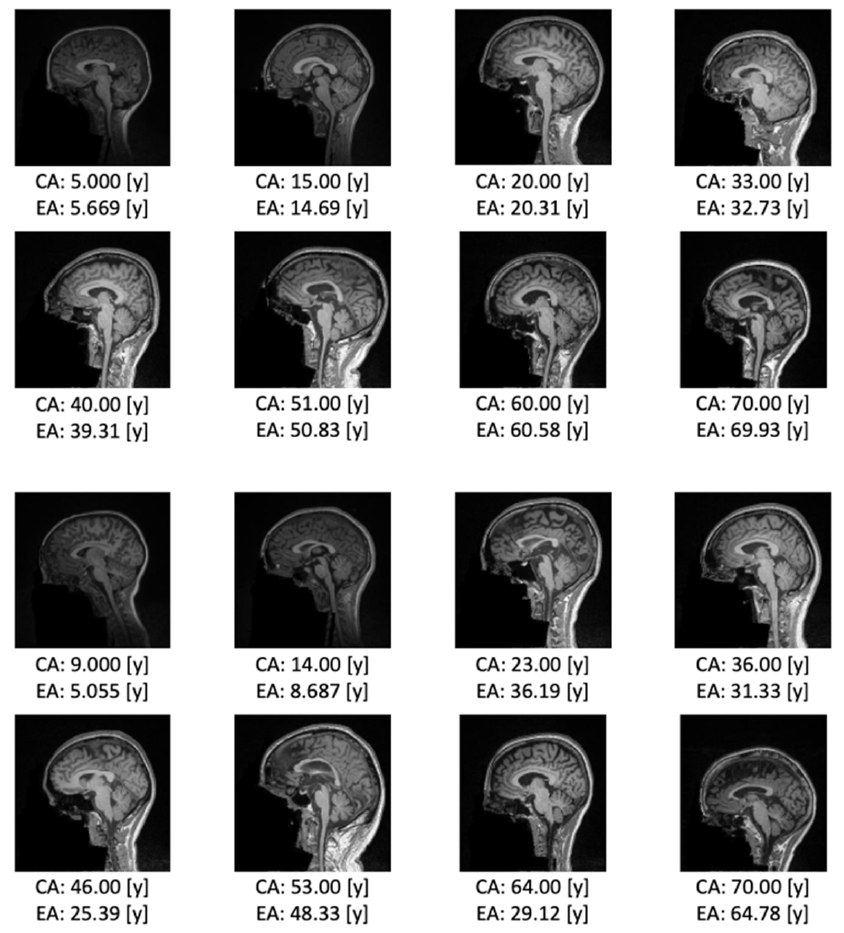
Figure 9. Typical example of this age estimation method. (CA, chronological age; EA, estimated age).